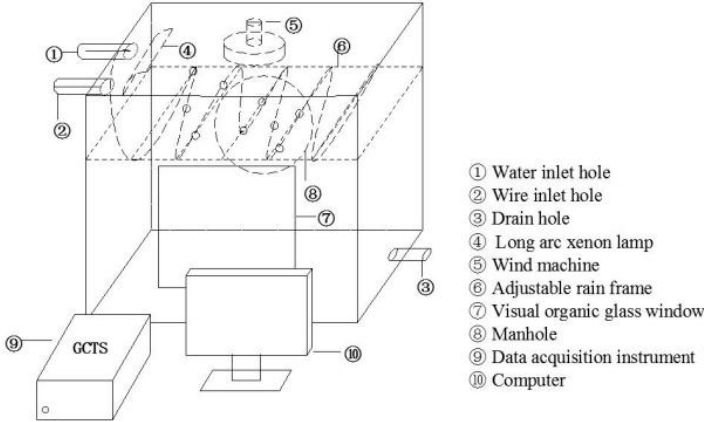
Figure 6. Schematic diagram of the environment box.